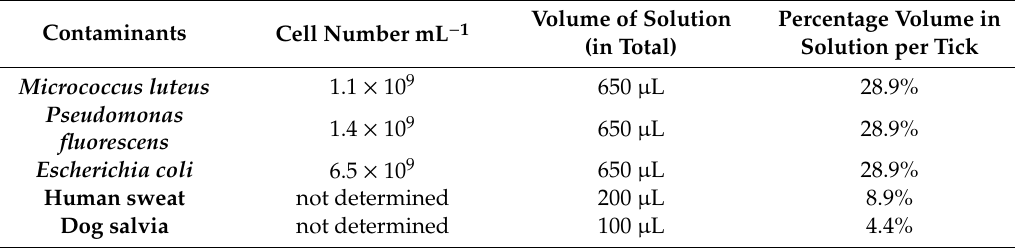
Table 2. Composition of defined contamination